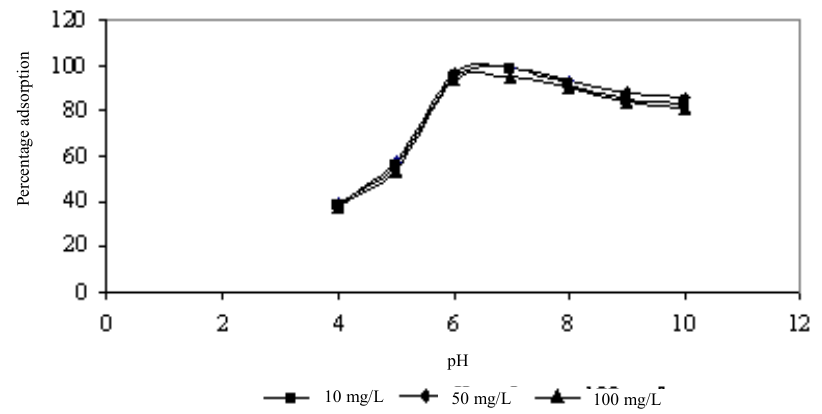
Figure 4 . The effect of pH on the UO 22+ adsorption capacity by